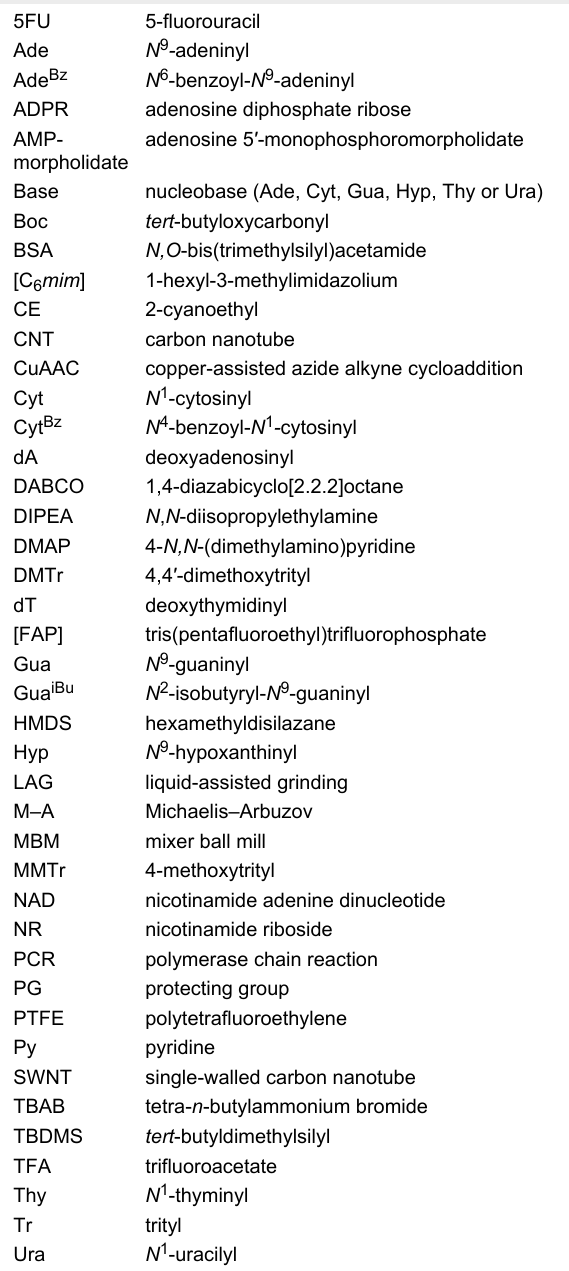
Table 1: List of